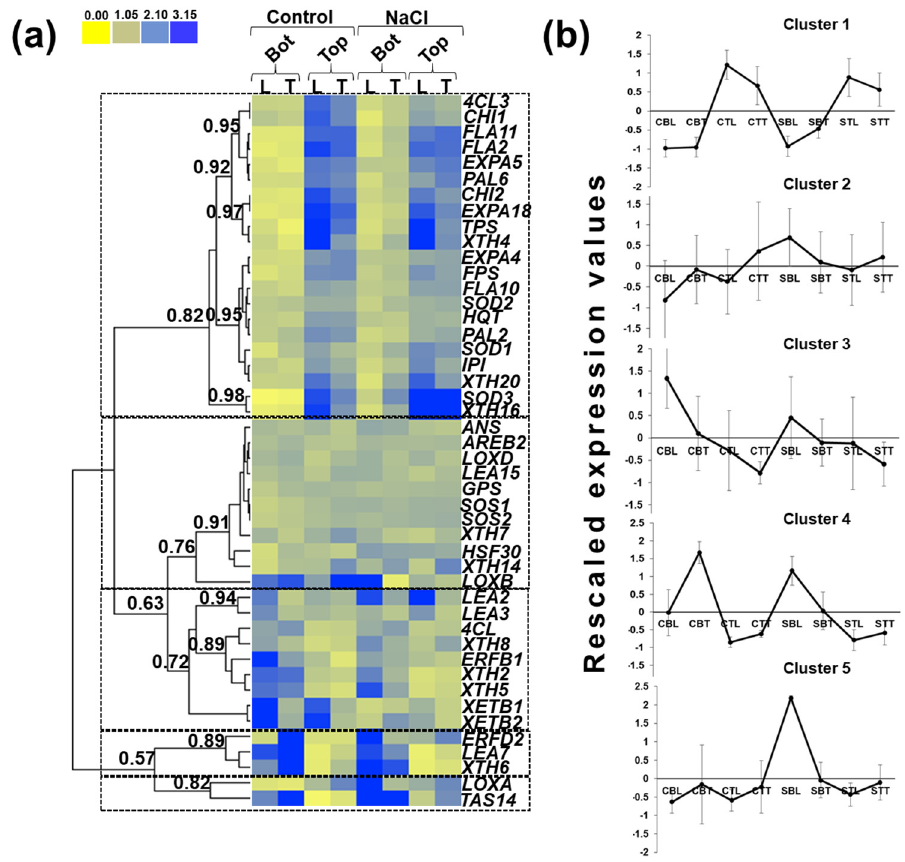
Figure 7. Gene expression analysis in Micro-Tom leaflets. ( a ) Heatmap hierarchical clustering (HC) of the gene expression data in control and stressed leaflets Micro-Tom exposed to 200 mM NaCl. The numbers refer to the Pearson’s correlation coefficients. The color bar indicates the pixel intensities which are directly proportional to the expression values. The dotted squares indicate the five clusters. CBL/SBL = control/salt-stressed bottom lateral leaflet; CBT/SBT = control/salt-stressed bottom terminal leaflet; CTL/STL = control/salt-stressed top lateral leaflet; CTT/STT = control/salt-stressed top terminal leaflet. ( b ) Rescaled expression values of each cluster. The rescaled values were calculated by subtracting from each expression value the average among the tissues and conditions and dividing by the standard deviation. 4CL = 4-coumarate-CoA ligase, ANS = anthocyanidin syn- thase; AREB = ABA responsive element-binding protein; CHI = chalcone isomerase; ERF = ethylene- response factor ; EXPA = expansin; FPS = farnesyl pyrophosphate synthase ; FLA = fasciclin-like arabinogalactan protein; GPS = geranyl pyrophosphate synthase; HQT = hydroxycinnamoyl-CoA quinate transferase; HSF = heat shock factor; IPI = isopentenyl pyrophosphate isomerase; LEA = late